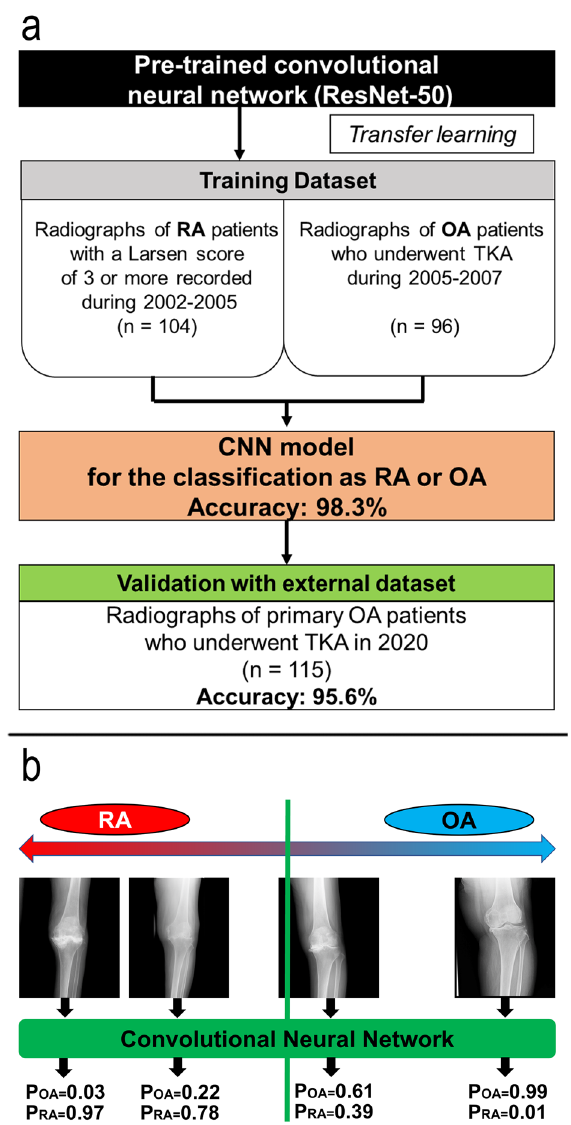
Figure 1. ( a ) Development of the deep learning model. An overview of the training and validation of the model. RA, rheumatoid arthritis; OA, osteoarthritis; TKA, total knee arthroplasty. ( b ) Concept of classification 0.5, the radiograph was classified into ‘OA’. POA, probability of osteoarthritis; PRA, probability of rheumatoid